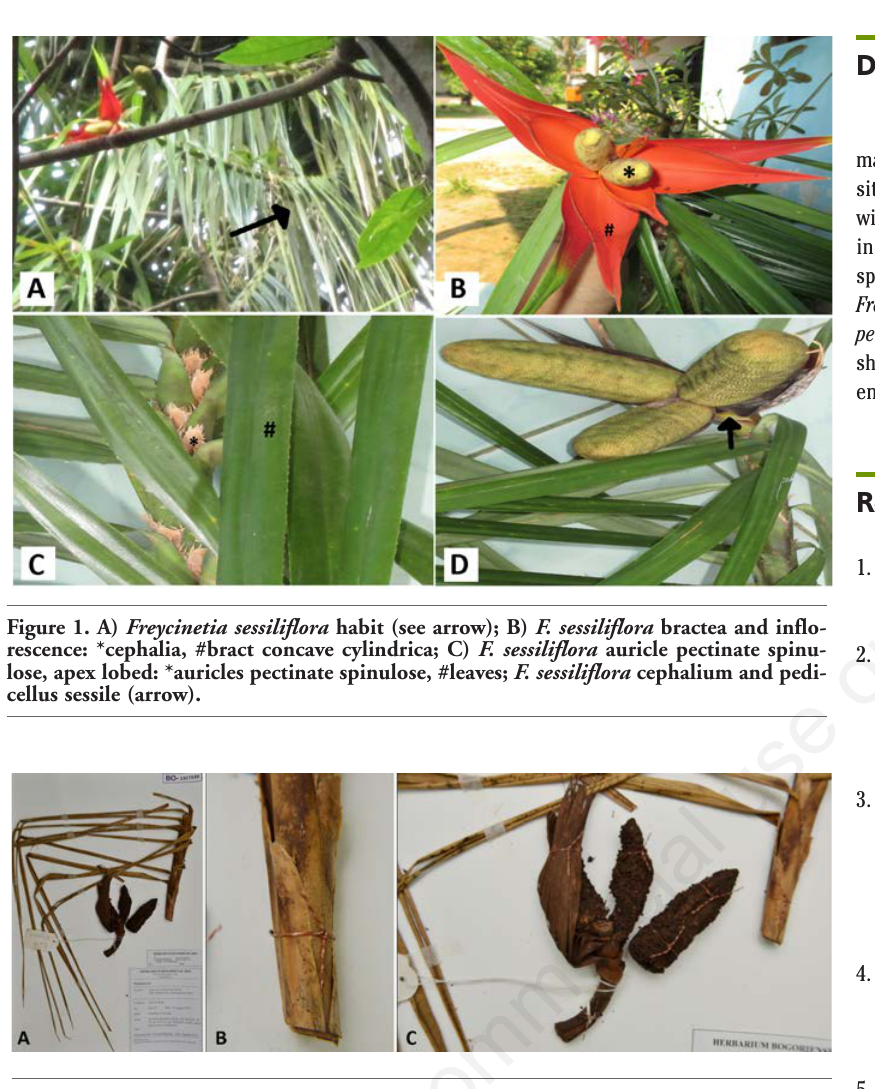
Figure 2. Holotype specimen of Freycinetia sessiliflora Rizki & Rugayah: A) F. sessiliflora; B) auricle of F. sessiliflora ; C) inflorescent of Freycinetia sessiliflora Rizki &